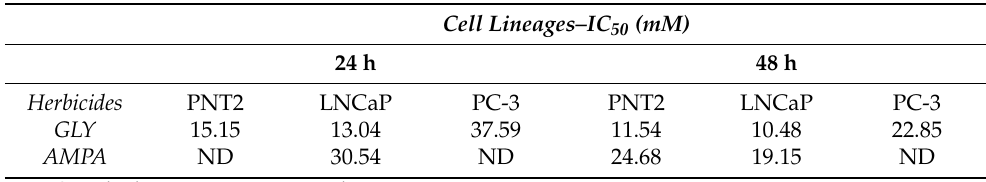
Table 1. IC 50 values for treatments of prostate cell lines with glyphosate (GLY) and aminomethyphos- phonic